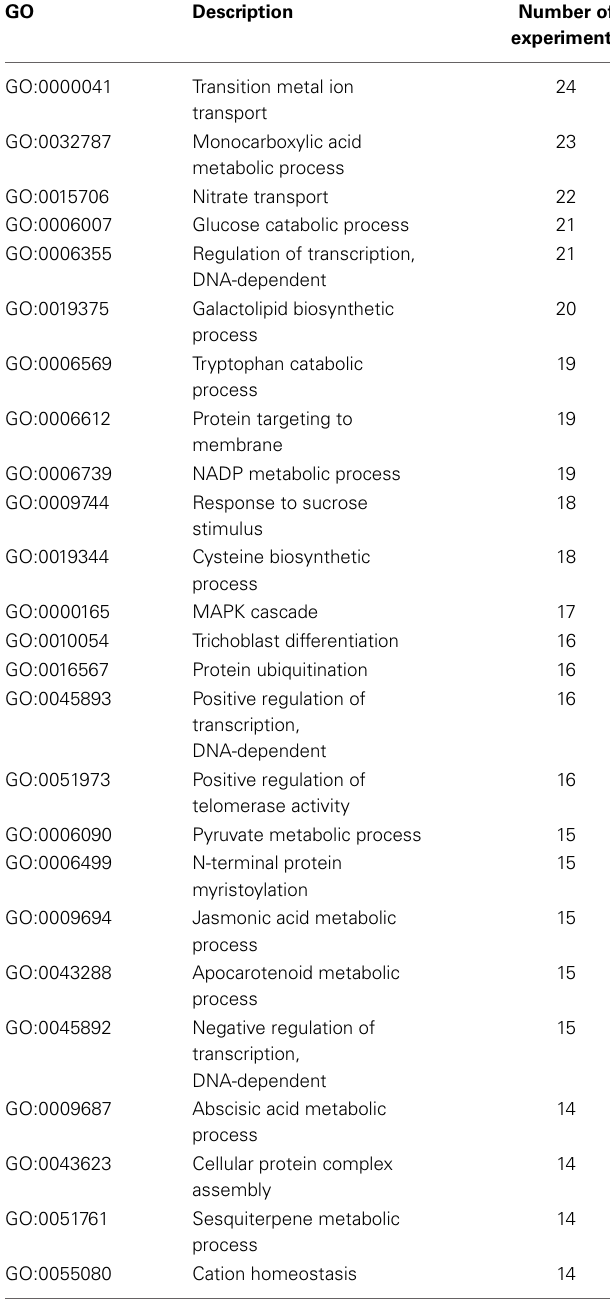
Table 3 | Ranking of the most consistent biological functions in the nitrate